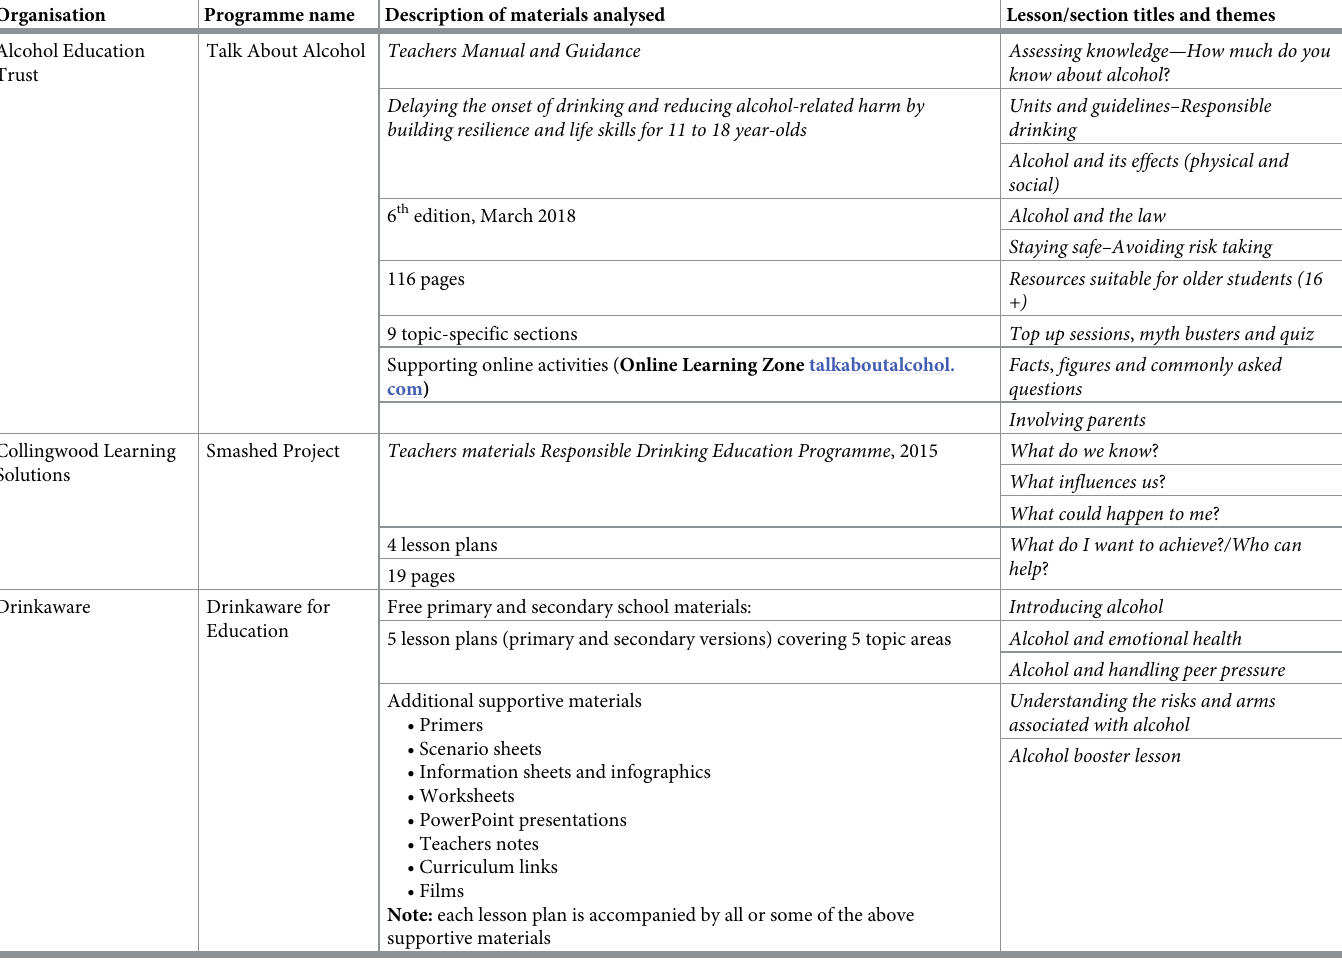
Table 1. Summary of the programmes, their provider organisations, types of materials